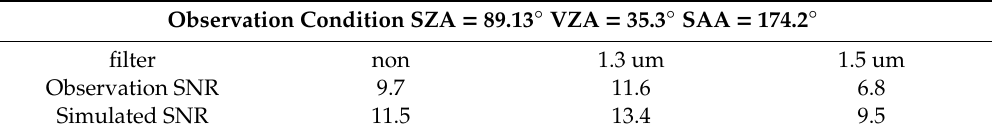
Table 6. Comparison between the observation results and the simulation results.